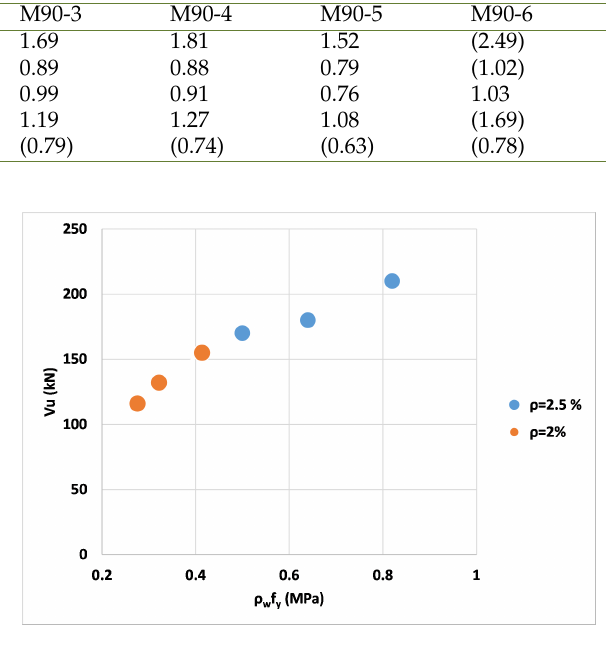
Fig. 4. Experimental V U as a function of ρ w f y